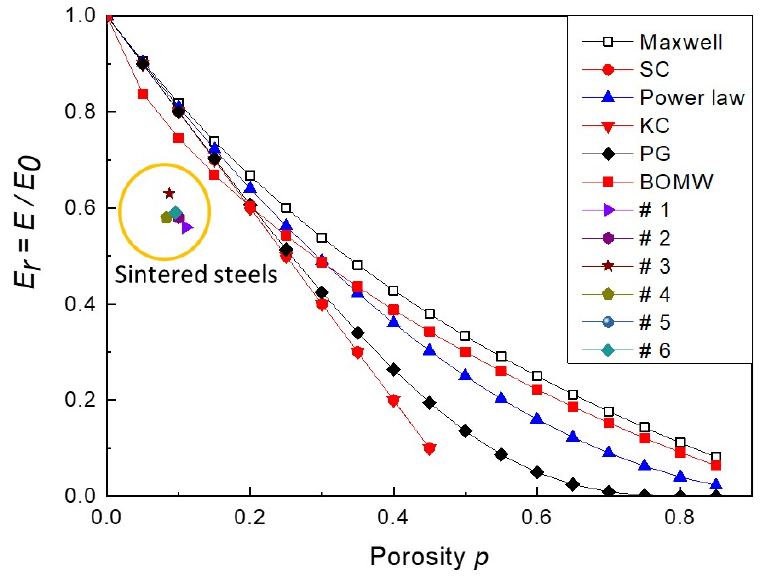
Figure 9. Trends of Er vs. porosity p calculated with the following expressions: Maxwell-type approximation, self-consistent (SC) approximation, power law, Krivoglaz and Cherevko (KC), Pabst and Gregorova (PG), and Bocaccini et. al. (BOMW) in the specific case of spherical pores.